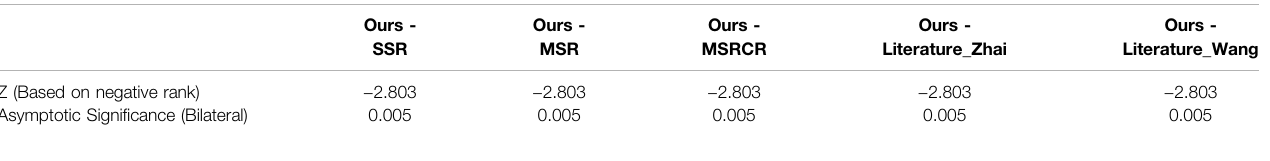
TABLE 9 | Wilcoxon signed rank test.